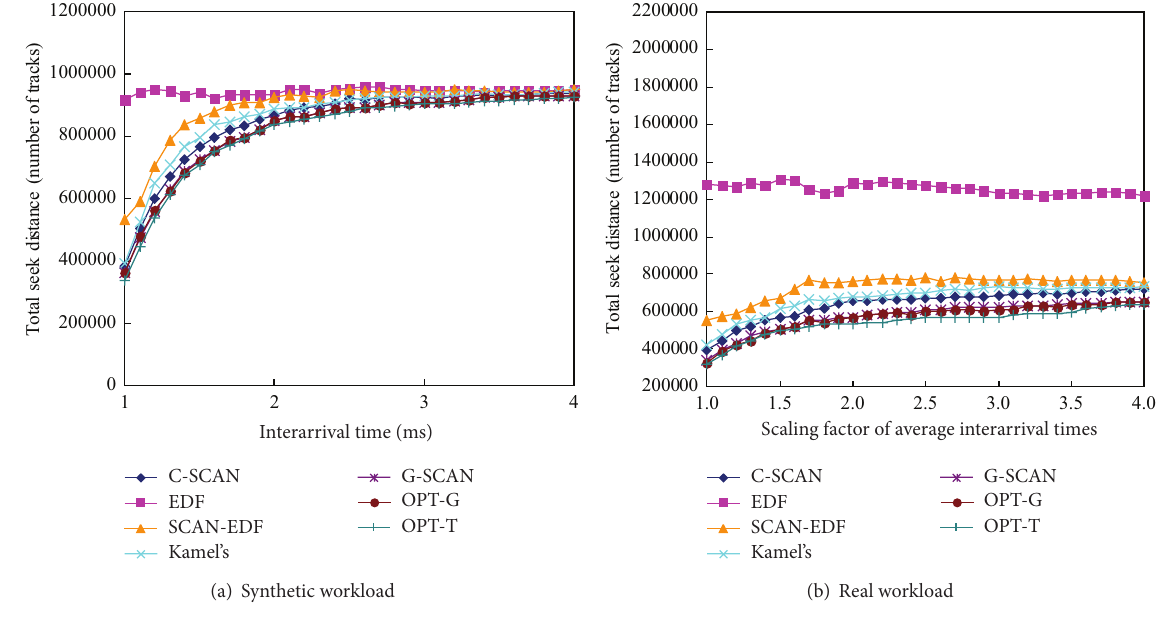
Figure 6: Total seek distances of the algorithms as a function of workload intensities.